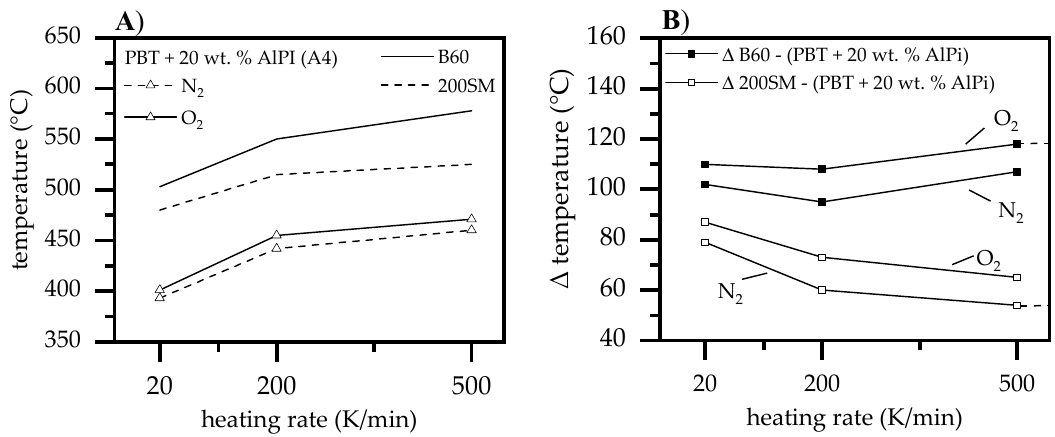
Figure 9. ( A ) Peak values of boehmite particles released 50% water as measured by the maximal and peak temperature of the derived mass change of PBT containing 20 wt.% AlPi ( B ) temperatures boehmite particles released 50% water as measured by the maximal release of water and subtracted from the gravimetric decomposition peak temperature of the derived mass change of PBT containing 20 wt.% AlPi.